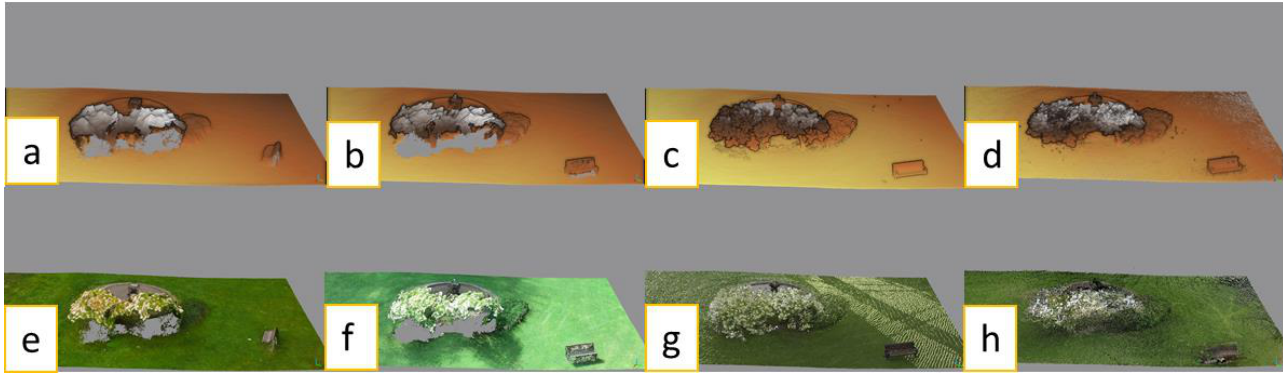
Figure 13. Comparisons of point clouds for plants with impressive blooming. In the top row, the point clouds are colored with the height ramp, and in the bottom row with RGB colorization.